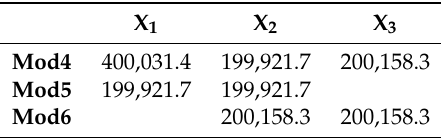
Table 4. VIFnc of Models 4–6 including the constant as an independent variable in a model without the intercept. X 1 X 2 X 3 Mod4 400,031.4